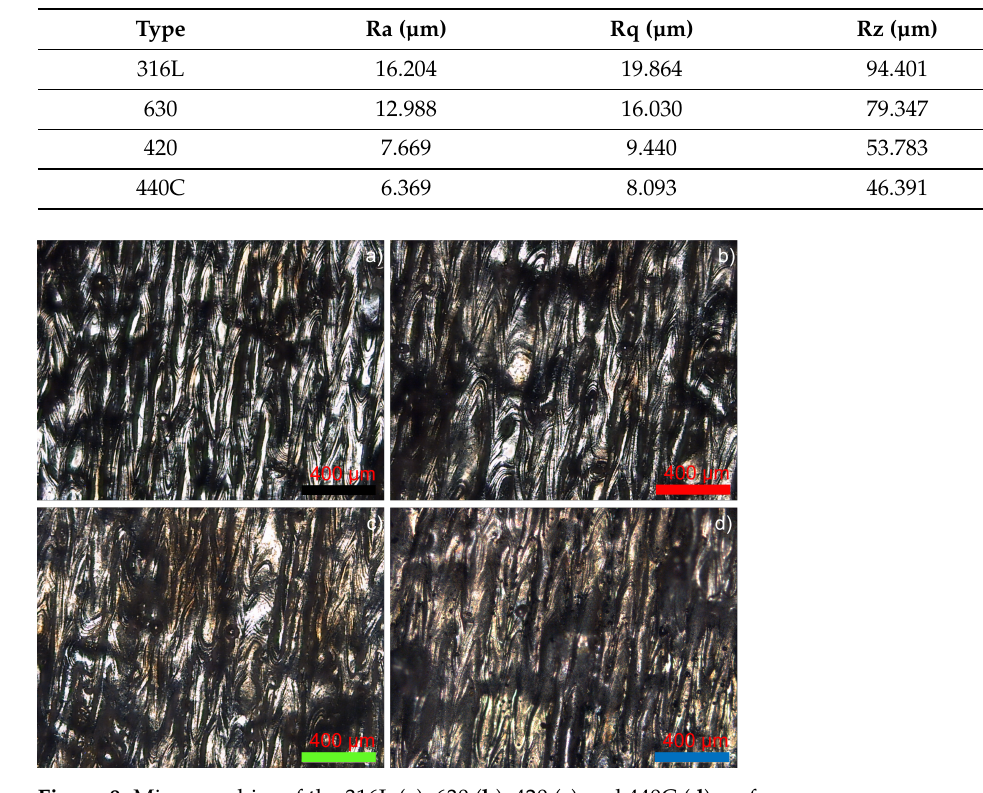
Figure 9. Micrographies of the 316L ( a ), 630 ( b ), 420 ( c ) and 440C ( d ) surfaces. Table 5. Comparison between CAD and final 3D object sizes of tensile test specimens, for each material type.